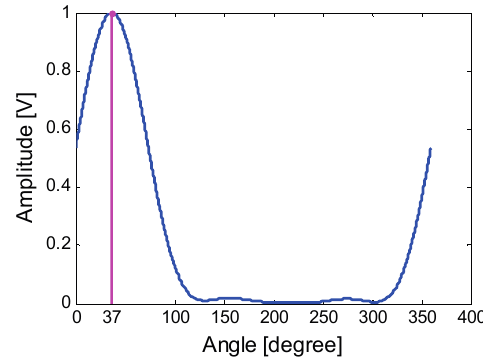
Figure 13. Azimuth estimation based on the acoustic vector sensor.